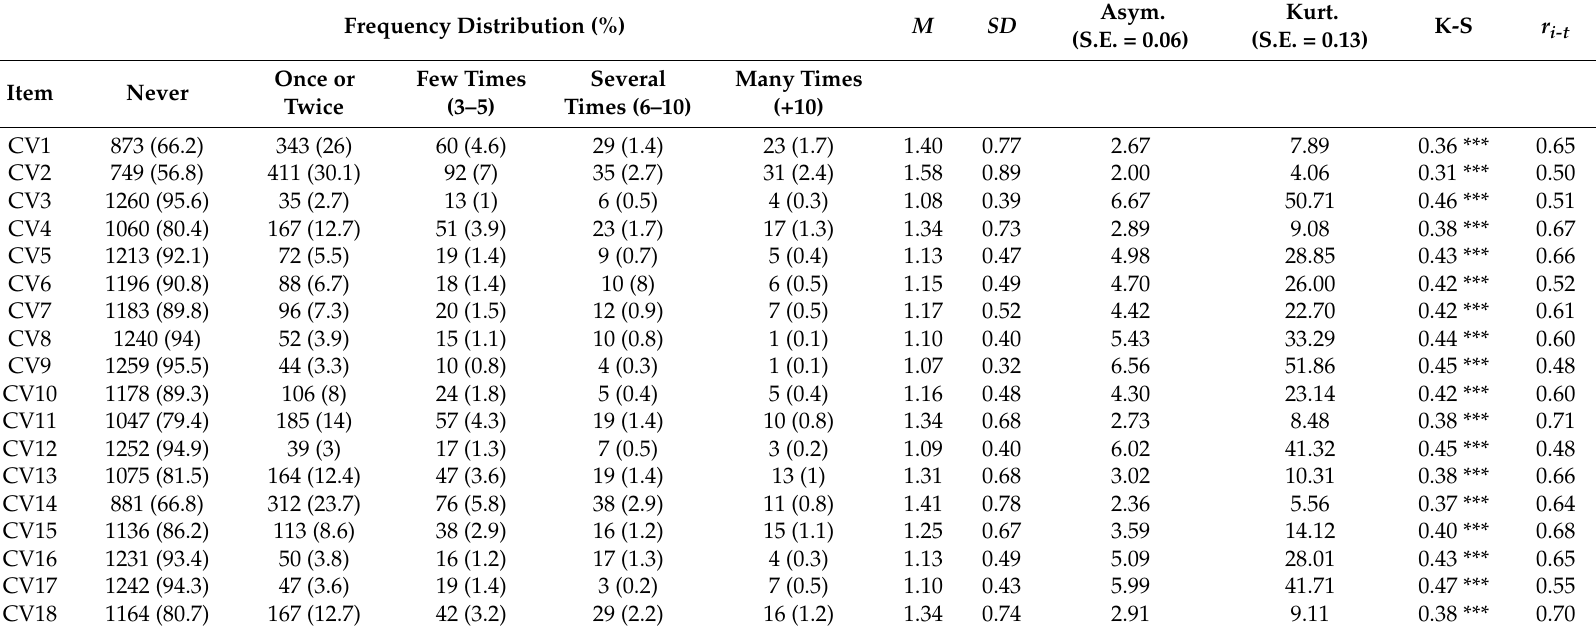
Table 1. Descriptive statistics for the